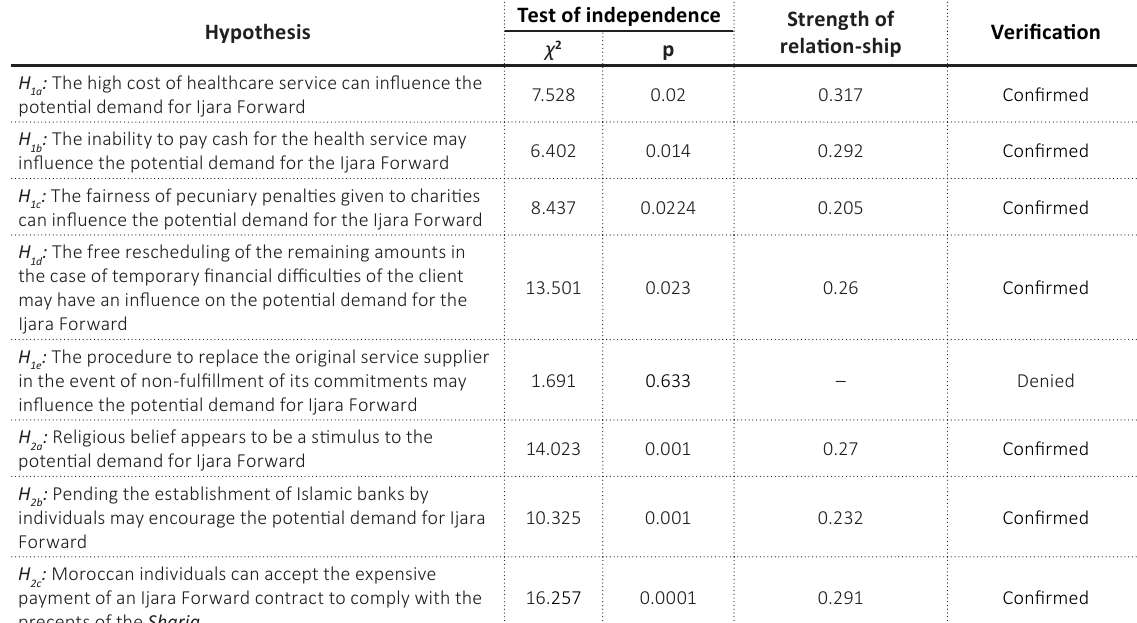
Table 2. Hypothesis